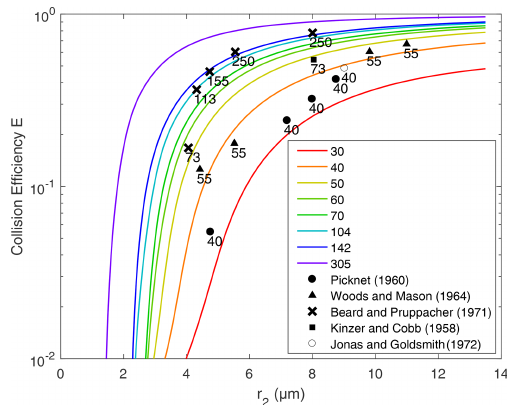
Figure 6. Collision efficiency for droplets with no electric charge or field. Lines are the results computed in this study. Different lines represent the different collector radius r 1 , from 30 to 305µm. The x axis denotes the collected droplet radius r 2 . Scatter points represent the collision efficiencies from previous experimental studies. The numbers next to these points represent the collector drop